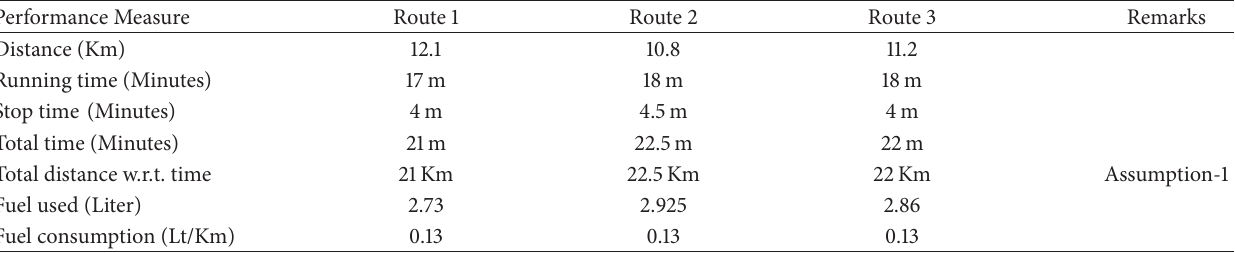
Table 4: Performance on moderate congestion road condition.